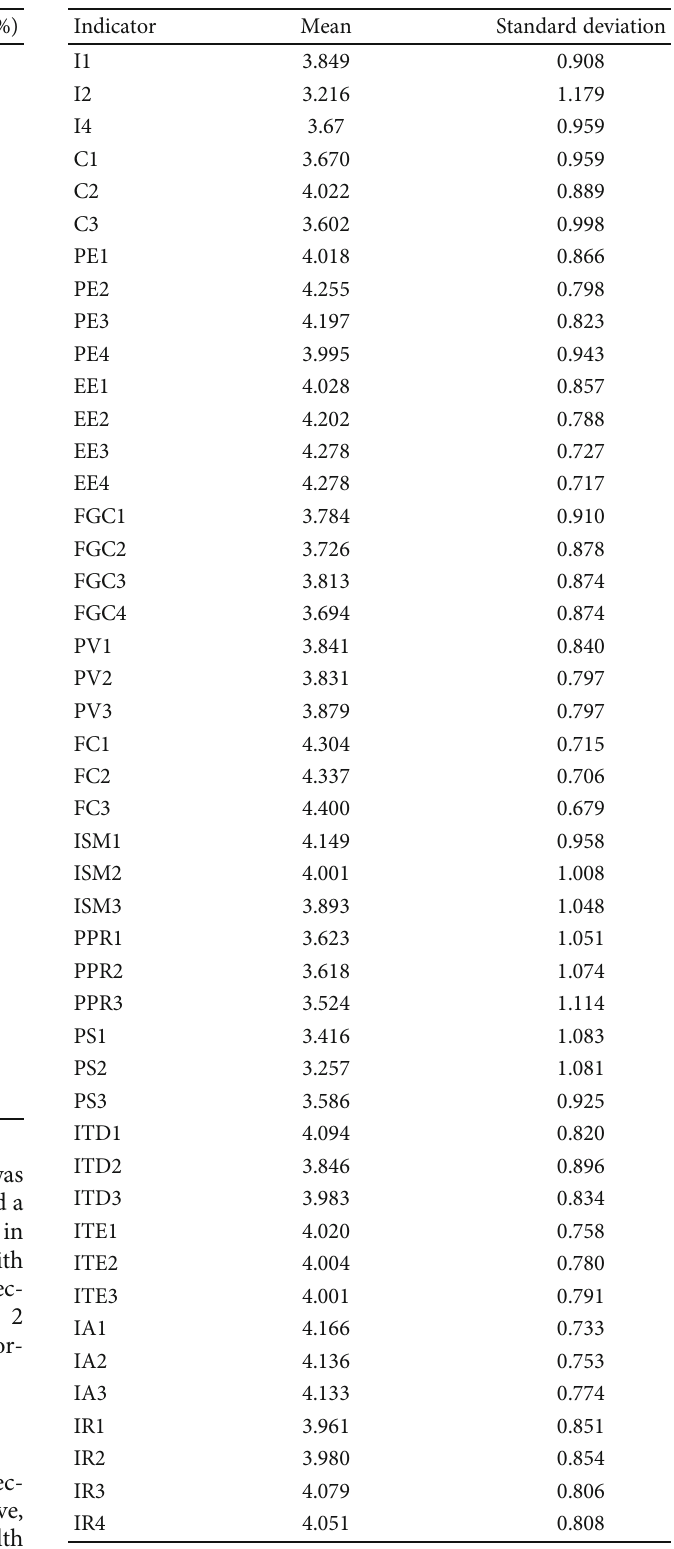
Table 3: Demographic data of the respondents ( N = 787 ). Table 4: Descriptive results of each item in every variable